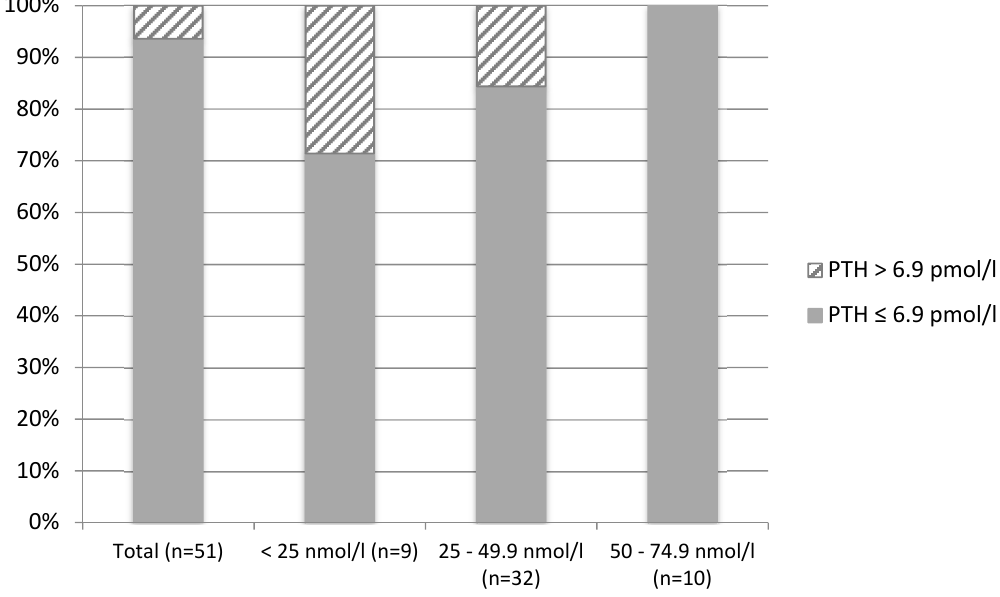
Figure 2. Prevalence of secondary hyperparathyroidism (PTH > 6.9 pmol/L) according to vitamin D status in Brazilian women living in England ( n = 51). There were no significant correlations between lumbar spine (L1–L4) and femur bone parameter measurements, determined by DXA, and PTH concentrations for women living in Brazil (Table